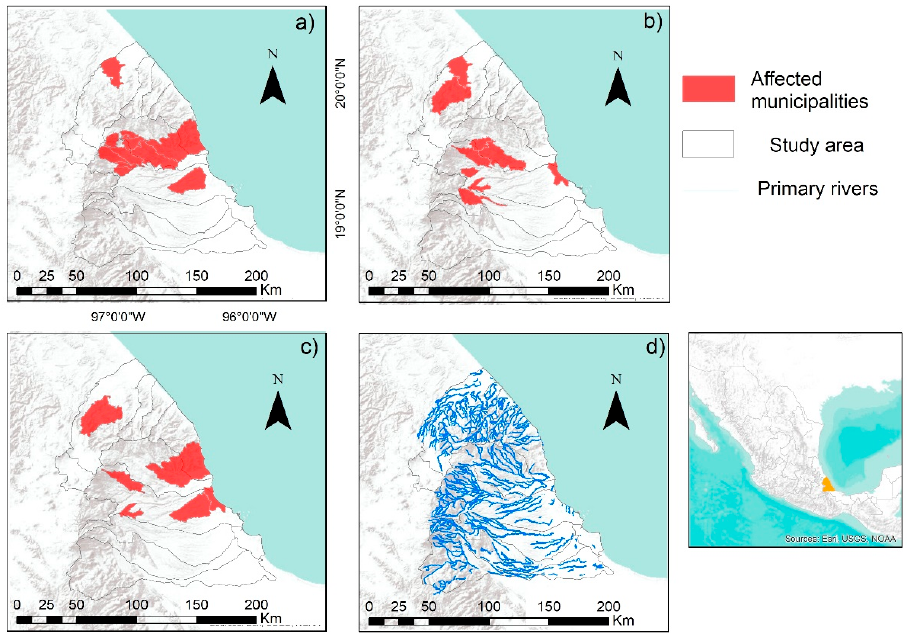
Figure 6. Municipalities affected by drought in the analysis variables. ( a ) Affected municipalities in corn crop yield, ( b ) affected municipalities in livestock cattle production volume, ( c ) affected municipalities in livestock cattle weight, and ( d ) river distribution in the study area [38] . Sources: Map modified from data obtained in the SMN (National Meteorological Service of Mexico) [42], INEGI (National Insititure of Statistics and Geography of Mexico) [38], ESRI (Environmental Systems Research Institute) [49].